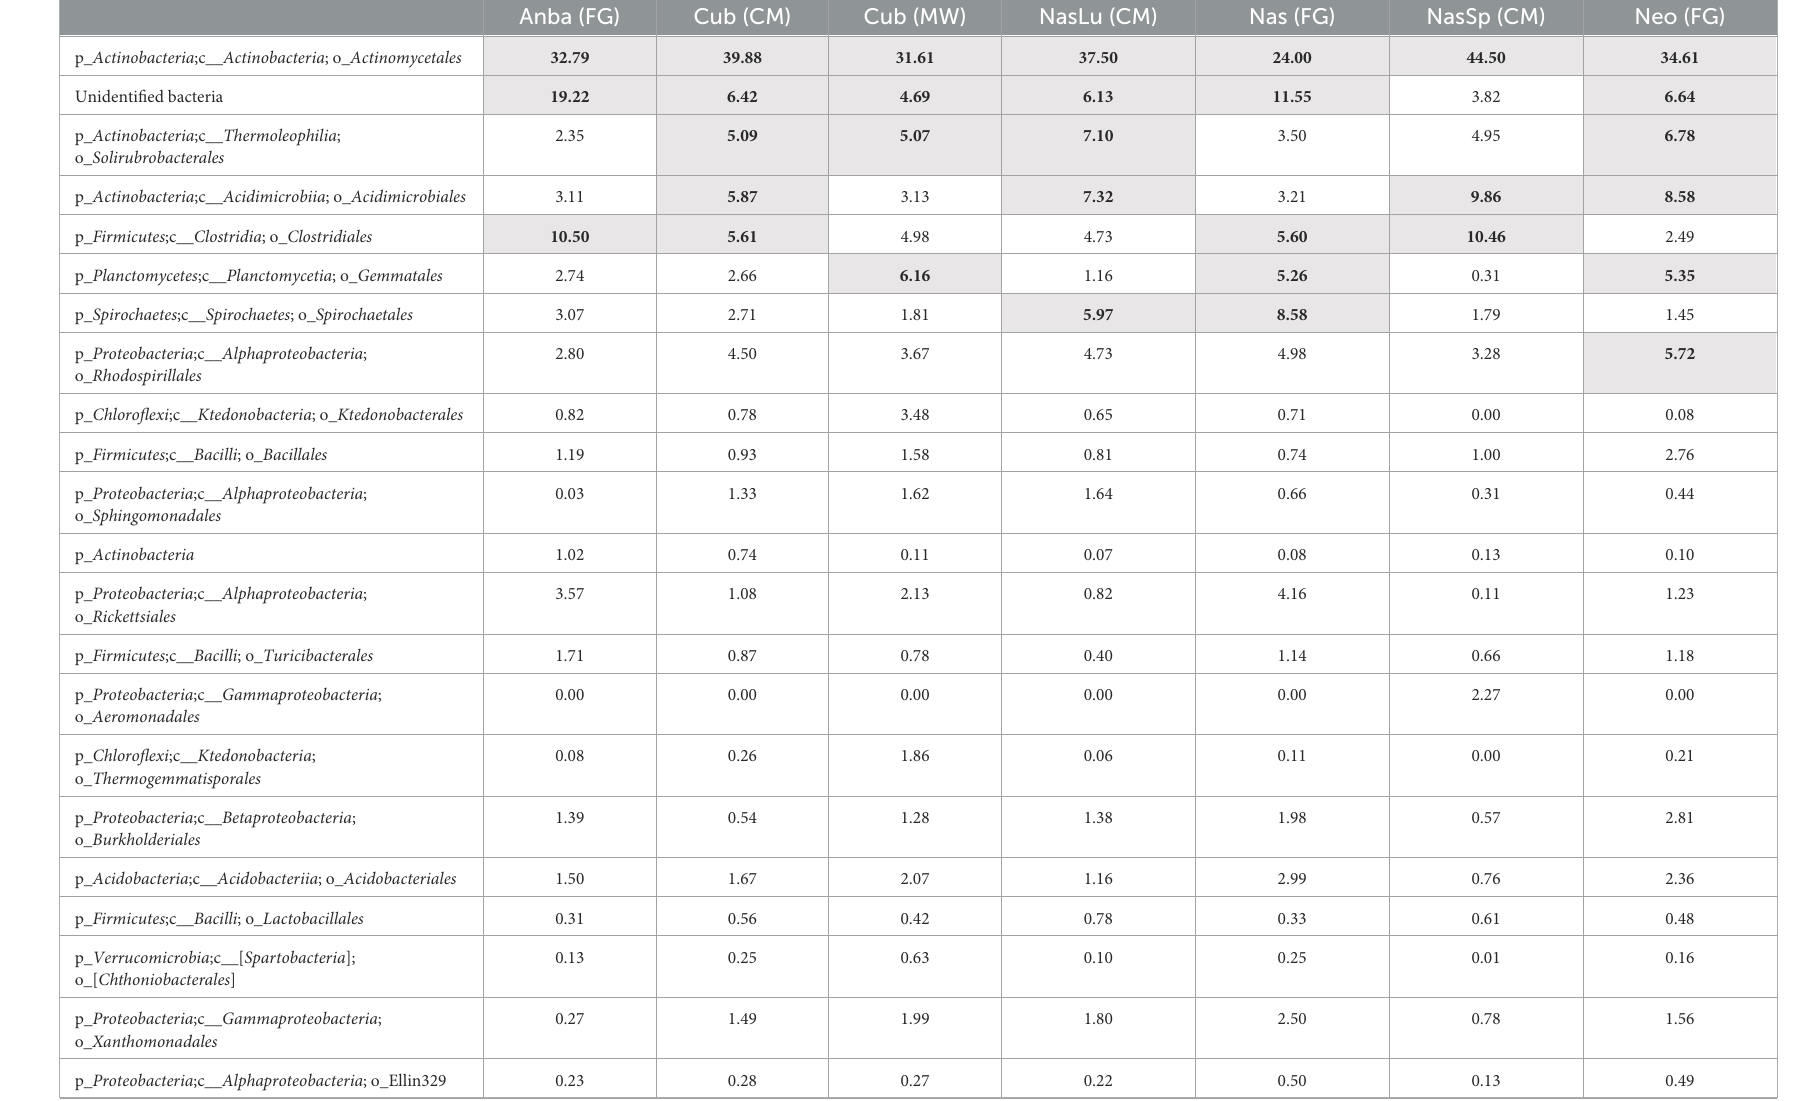
TABLE 3 Taxonomic overview of the samples retained for further analyses (with more than two representatives per